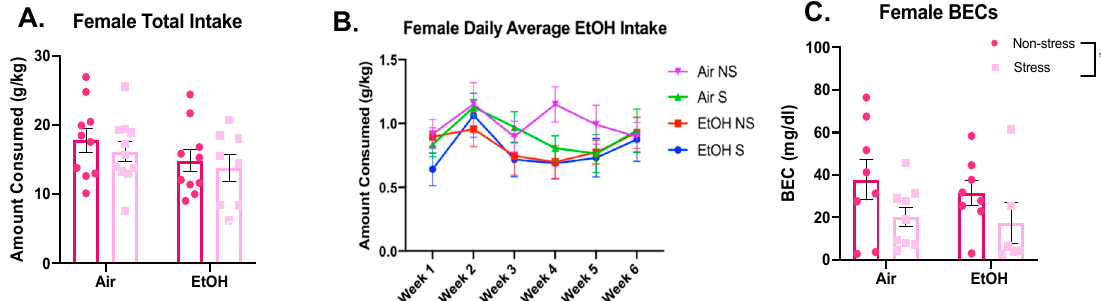
Figure 9. Female voluntary ethanol (10%) intake following FSS. Cumulative intake across the eighteen drinking sessions ( A ) and intake averages for each week ( B ) are shown alongside BECs taken immediately after the final drinking session ( C ). No significant effects of ethanol exposure or stress for either intake measure. Significant stress effect in BECs denoted as * p < 0.05.